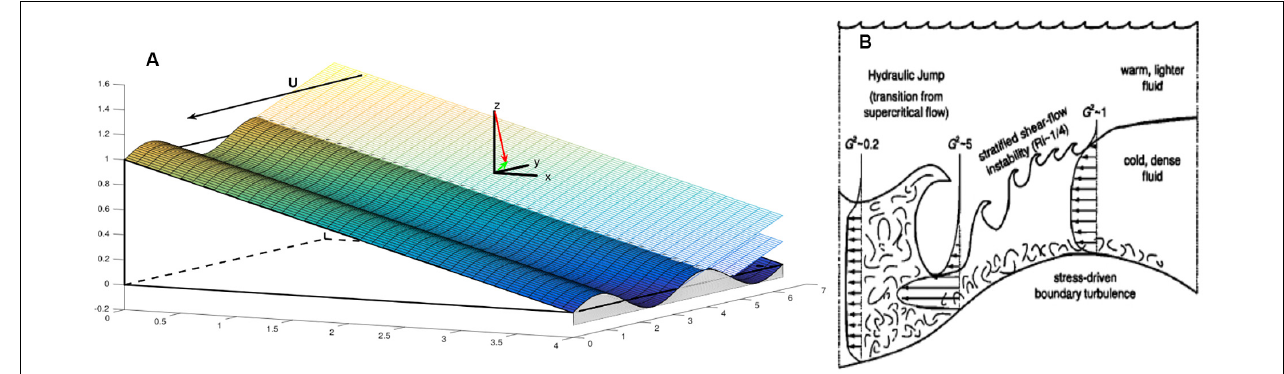
FIGURE 2 | Class #2: Mean flows – lee waves and hydraulics. Mean flow over irregular topography can induce radiating internal waves if the topographic irregularities superimposed on the slope have a “small” amplitude ( A , after Thorpe, 1992). In this case one assumes a quasi-stationary internal wave response that varies on the time scale of the background flow. Mean flow direction is indicated by the arrow in association with U. A right-hand x – y – z coordinate system defines the orientation of the wave vector (red) normal to the wave phase planes and its projection upon the horizontal (green), in the upslope direction. Intense mixing can occur if the topographic irregularities are ‘finite amplitude’ and a parameter regime of internal hydraulics is entered ( B , following Nash and Moum, 2001). Turbulence and mixing occur in conjunction with bottom stress in an accelerating downslope jet, high shear on an interface with overlying fluid and within the hydraulic transition (jump). Without the inclined plane, the dynamical transition between waves and hydraulics occurs when the topographic perturbations have an amplitude similar to that of the lee wave, flow blocking initiates and vertical shear in the wave response is approximately equal to the buoyancy frequency N. The dynamical impact of the inclined plane is largely unexplored.